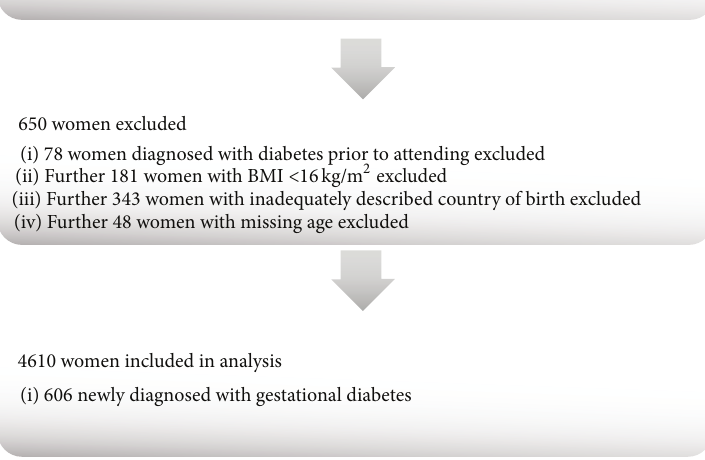
Figure 1: Flow chart of women who gave birth at Sunshine Hospital from 1st July 2012 to 30th June 2013 showing numbers included in and excluded from